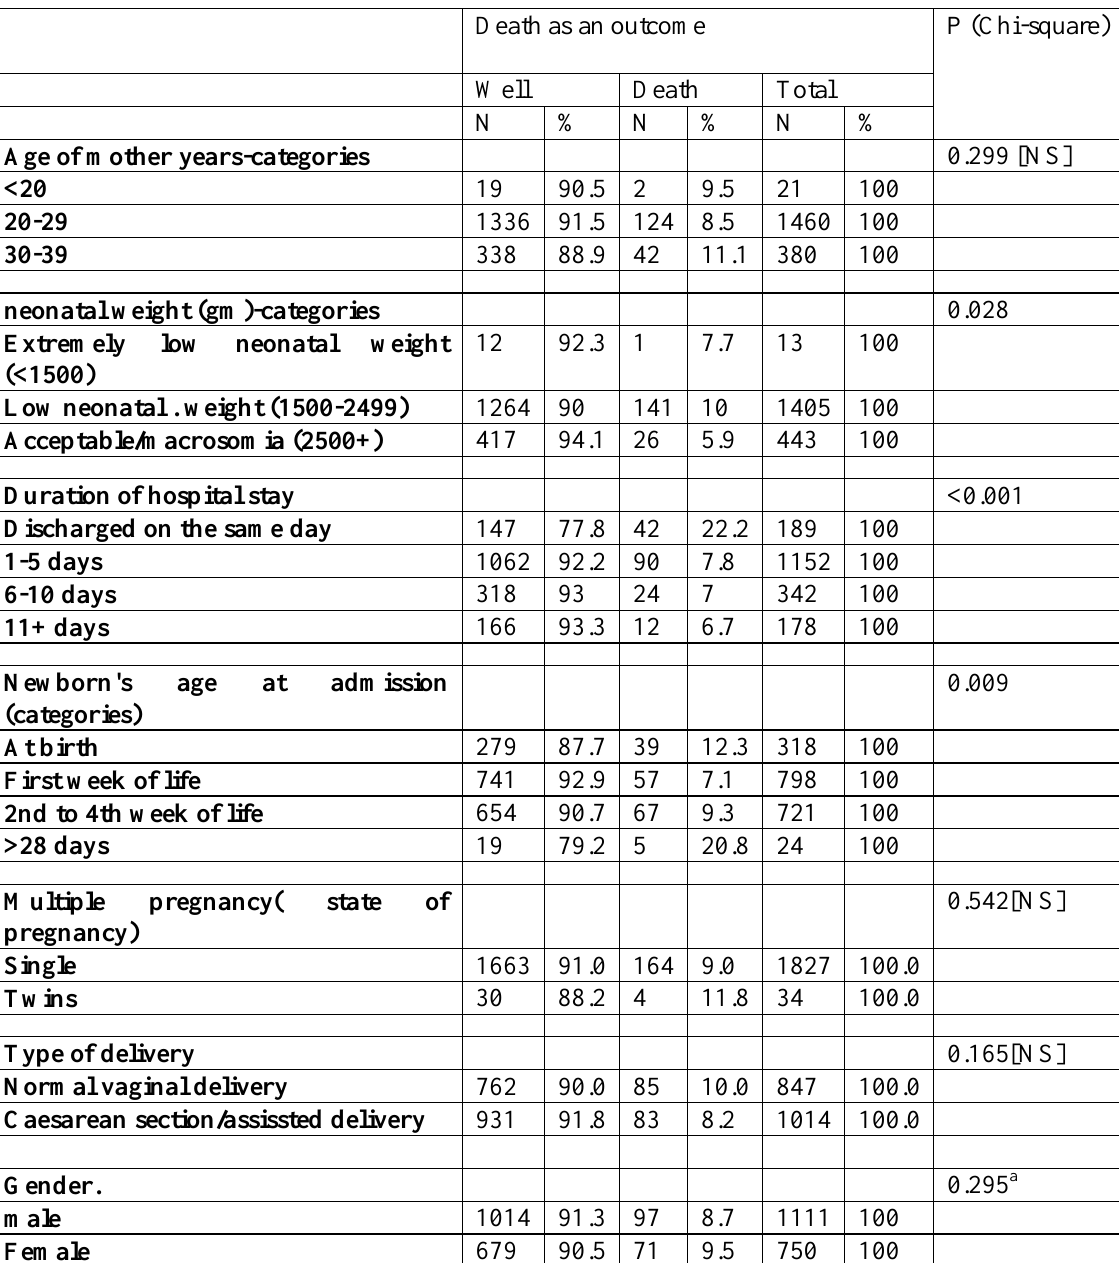
Table 6: The case fatality rate by selected explanatory variables Death as an outcome P